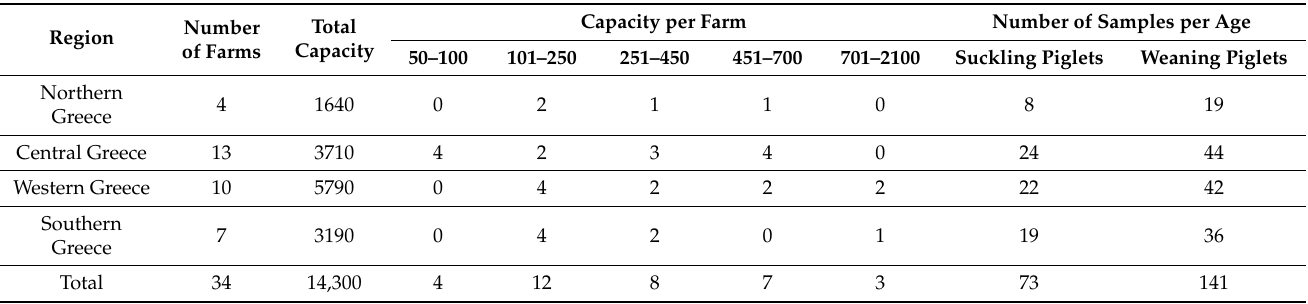
Table 1. Geographic origin and capacity of study’s farms.